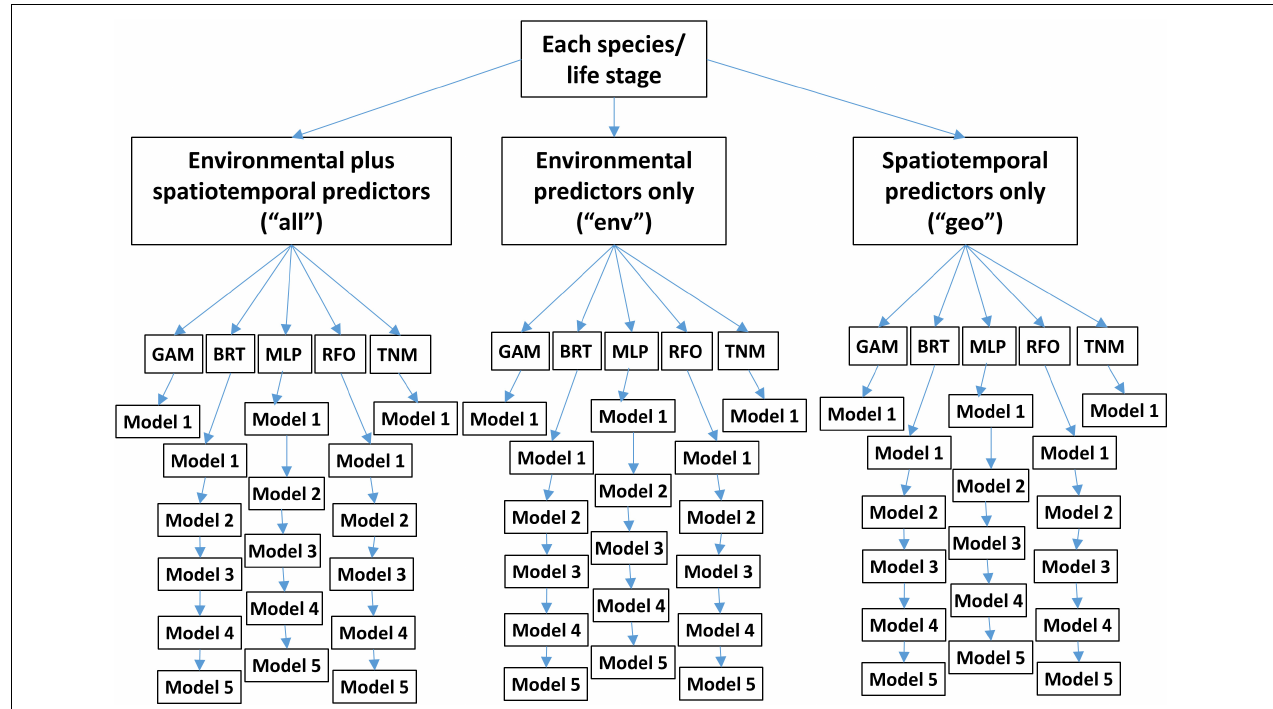
FIGURE 2 | Conceptual diagram of SDM ensembles used for each of the two modeling experiments. “GAM” denotes Generalized Additive Models, “BRT” Boosted Regression Trees, “MLP” Multilayer Perceptrons, “RFO” Random Forests, and “TNM” Thermal Niche Models. Note that these ensembles are replicated 10 times for different random splits of the training/testing